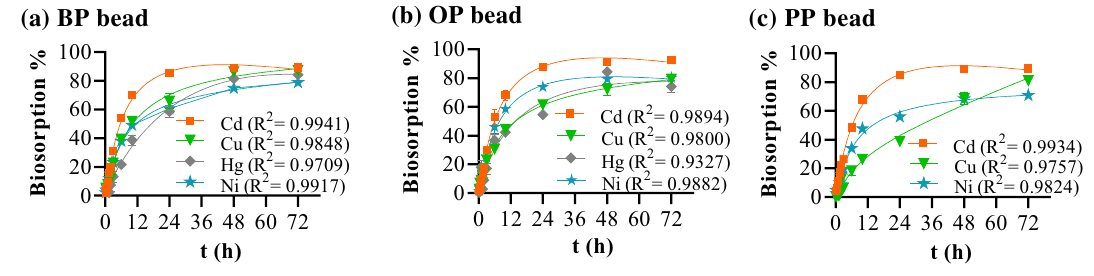
Fig. 4 Effect of contact time on biosorption. One bead was incubated in a cocktail solution containing all seven ions each at 0.1 mgL-1, pH 7.0, 25 °C with continuous shaking at 250 rpm for 15 min–72 h. The